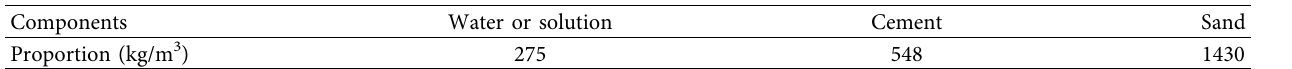
Table 2: Mix design of